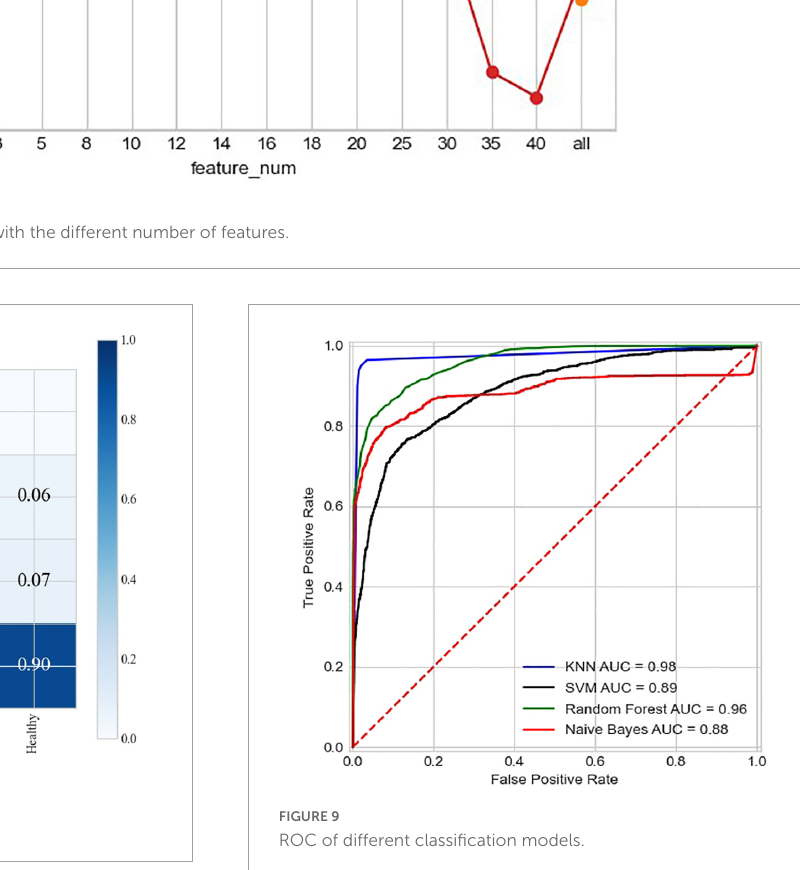
Figure 4 shows that patients with different grades of hemiplegia showed significant differences in step length and knee motion range. Generally, the knee motion range and